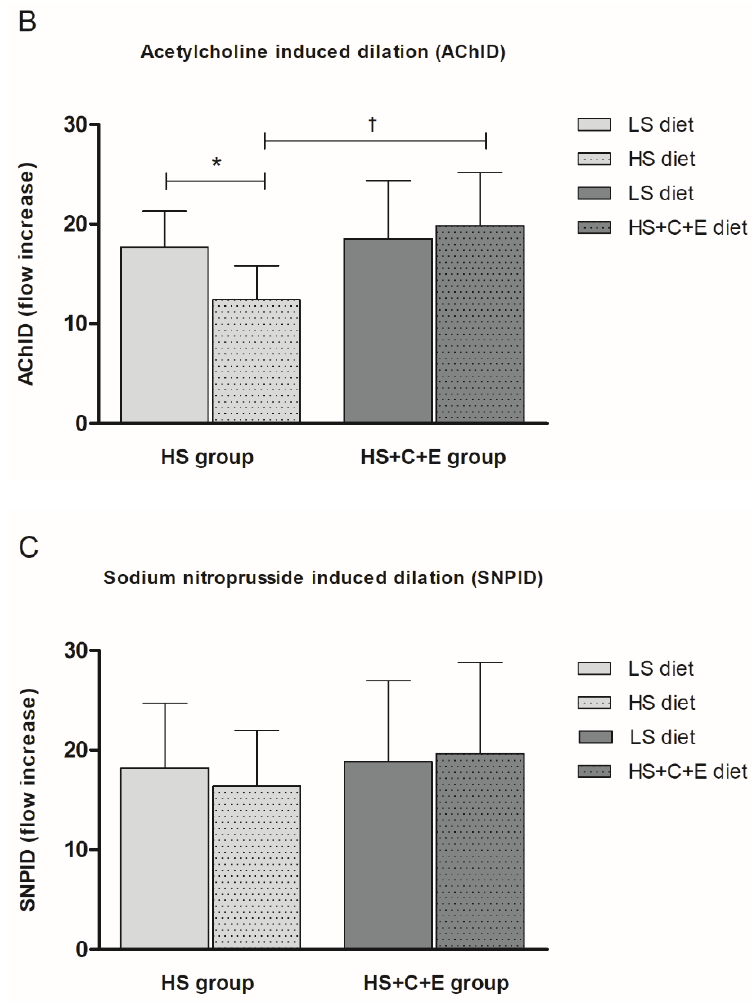
Figure 1. The effect of the 7-day high-salt (HS) diet without (HS group) and with vitamin C and E (HS+C+E group) supplementation on skin microvascular reactivity in young healthy individuals. ( A ) Post-occlusive reactive hyperemia (PORH), ( B ) Acetylcholine-induced dilation (AChID), and ( C ) Sodium nitroprusside induced dilation (SNPID). PORH measurement is expressed as the difference between percentage of flow change during reperfusion and occlusion in relation with baseline (R-O%). AChID and SNPID are expressed as flow increase following ACh or SNP administration compared to baseline flow. Data are presented as average ± SD. LS- low-salt; HS- high-salt; HS+C+E- high-salt + C vitamin + E vitamin; R-O%- change of microvascular blood flow between reperfusion and occlusion (in relation to baseline); AChID- acetylcholine induced dilation; SNPID- sodium nitroprusside induced dilation. * p < 0.05, LS diet vs. HS diet within the HS group. † p < 0.05 HS diet vs. HS+C+E diet.